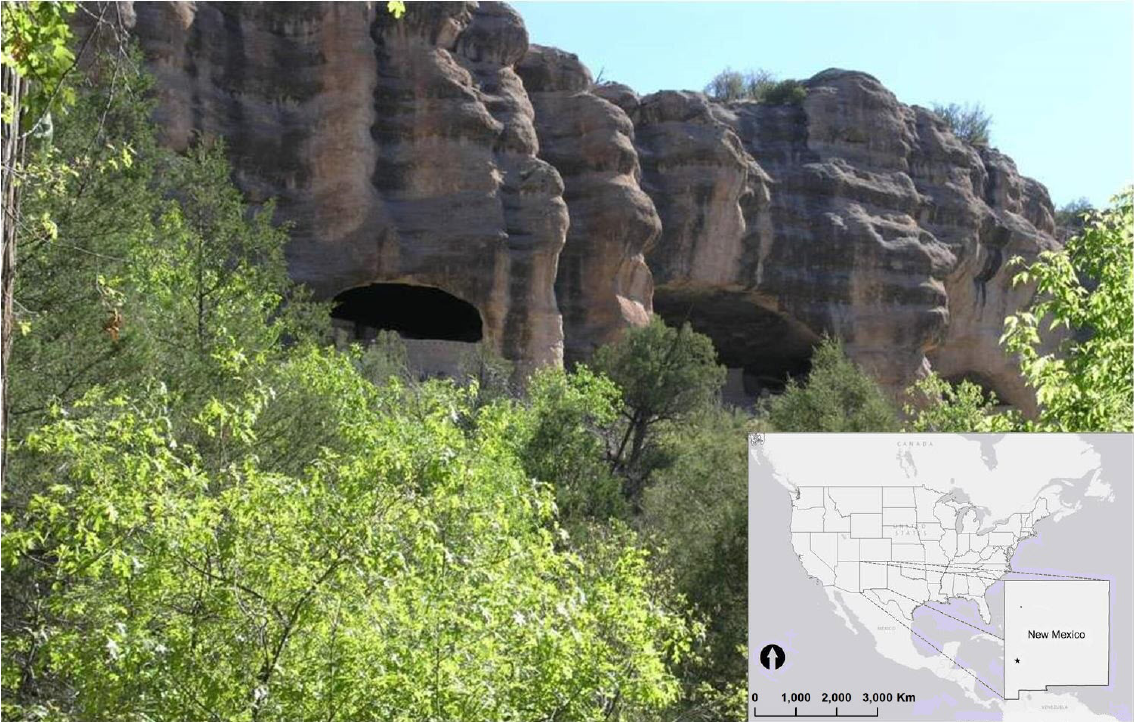
Figure 1. Several of the caves at Gila Cliff Dwellings National Monument, with location map inset. The map was created for this publication by Patrick T. Doyle using ArcGIS software by ESRI. The base layer for the map was obtained through ESRI by ArcGIS Online data